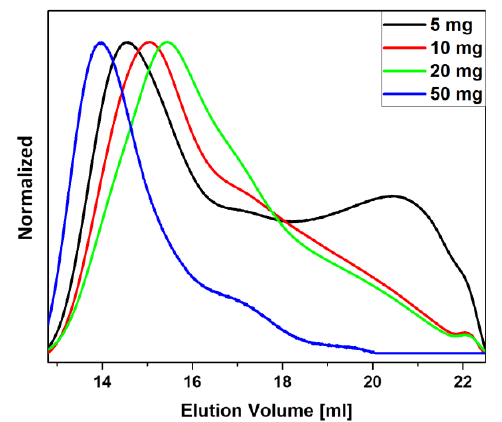
Figure 8. SEC elution traces (DMAc/LiCl) of PS synthesized by free radical polymerization in the presence of different amounts of MPTS@MCNP as chain transfer agent: black line: PS obtained in the presence of 5 mg ( M n = 6.900 kg mol −1 ; Ð = 9.6); red line: PS (10 mg, M n = 12.800 kg mol −1 ; Ð = 5.2); green line: PS (20 mg, M n = 13.300 kg mol −1 ; Ð = 4.5); blue line: PS (50 mg, M n = 62.600 kg mol −1 ; Ð = 2.8).